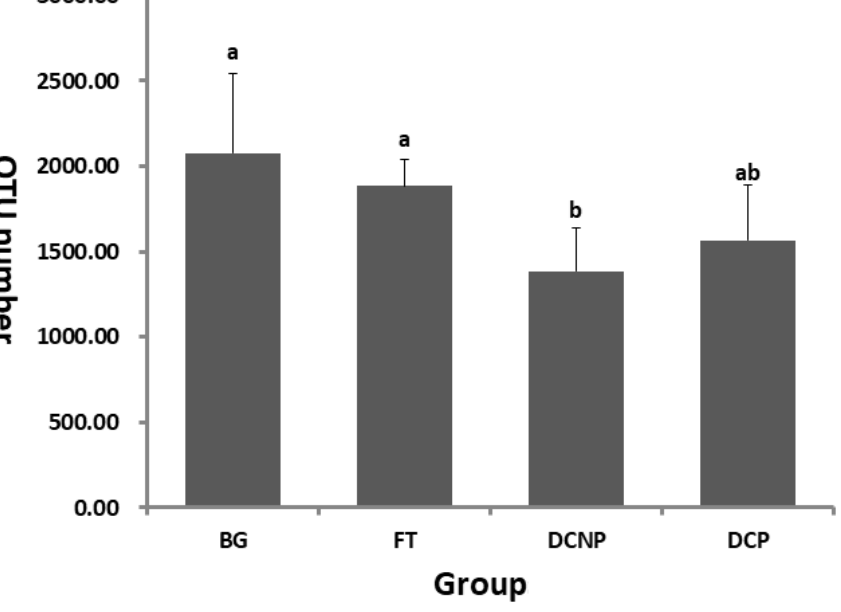
Figure 1. Histogram of the number of OTUs in the four groups. Different letters indicate a significant difference among groups ( p < 0.05), while the same letter indicates no difference among groups ( p > 0.05).